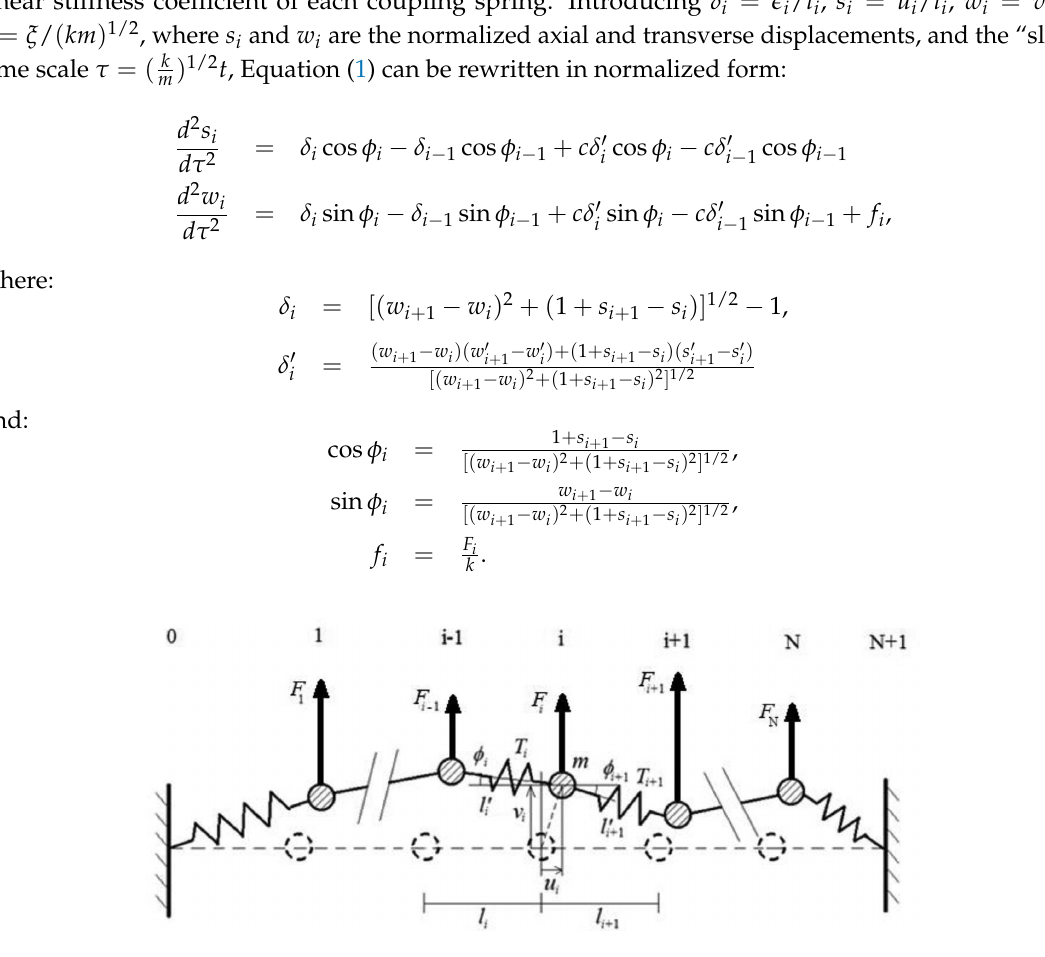
Figure 1. Forced and damped lattice oscillating in the plane (see